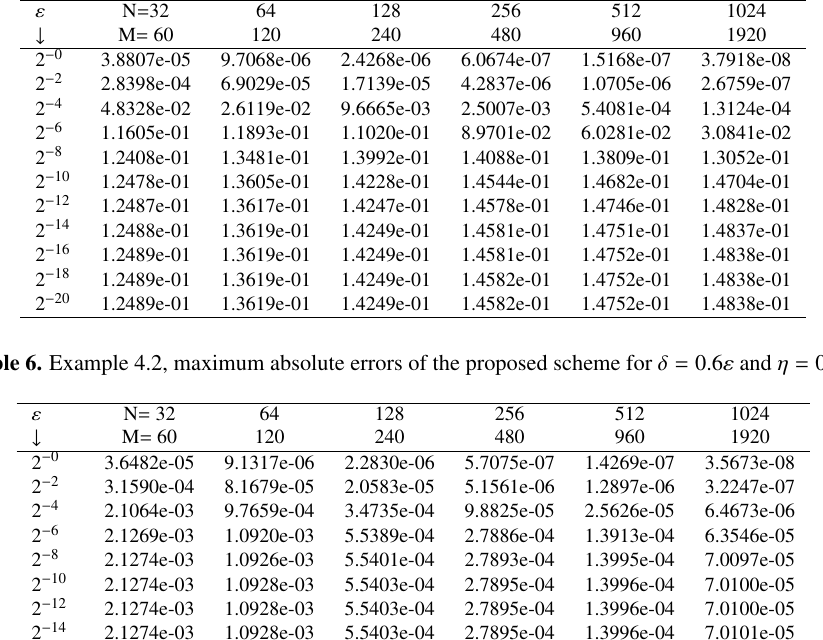
Table 5. Example 4.2, maximum absolute errors of the scheme without the exponential fitting factor ( σ ) for δ = 0 . 6 ε and η = 0 . 5 ε .